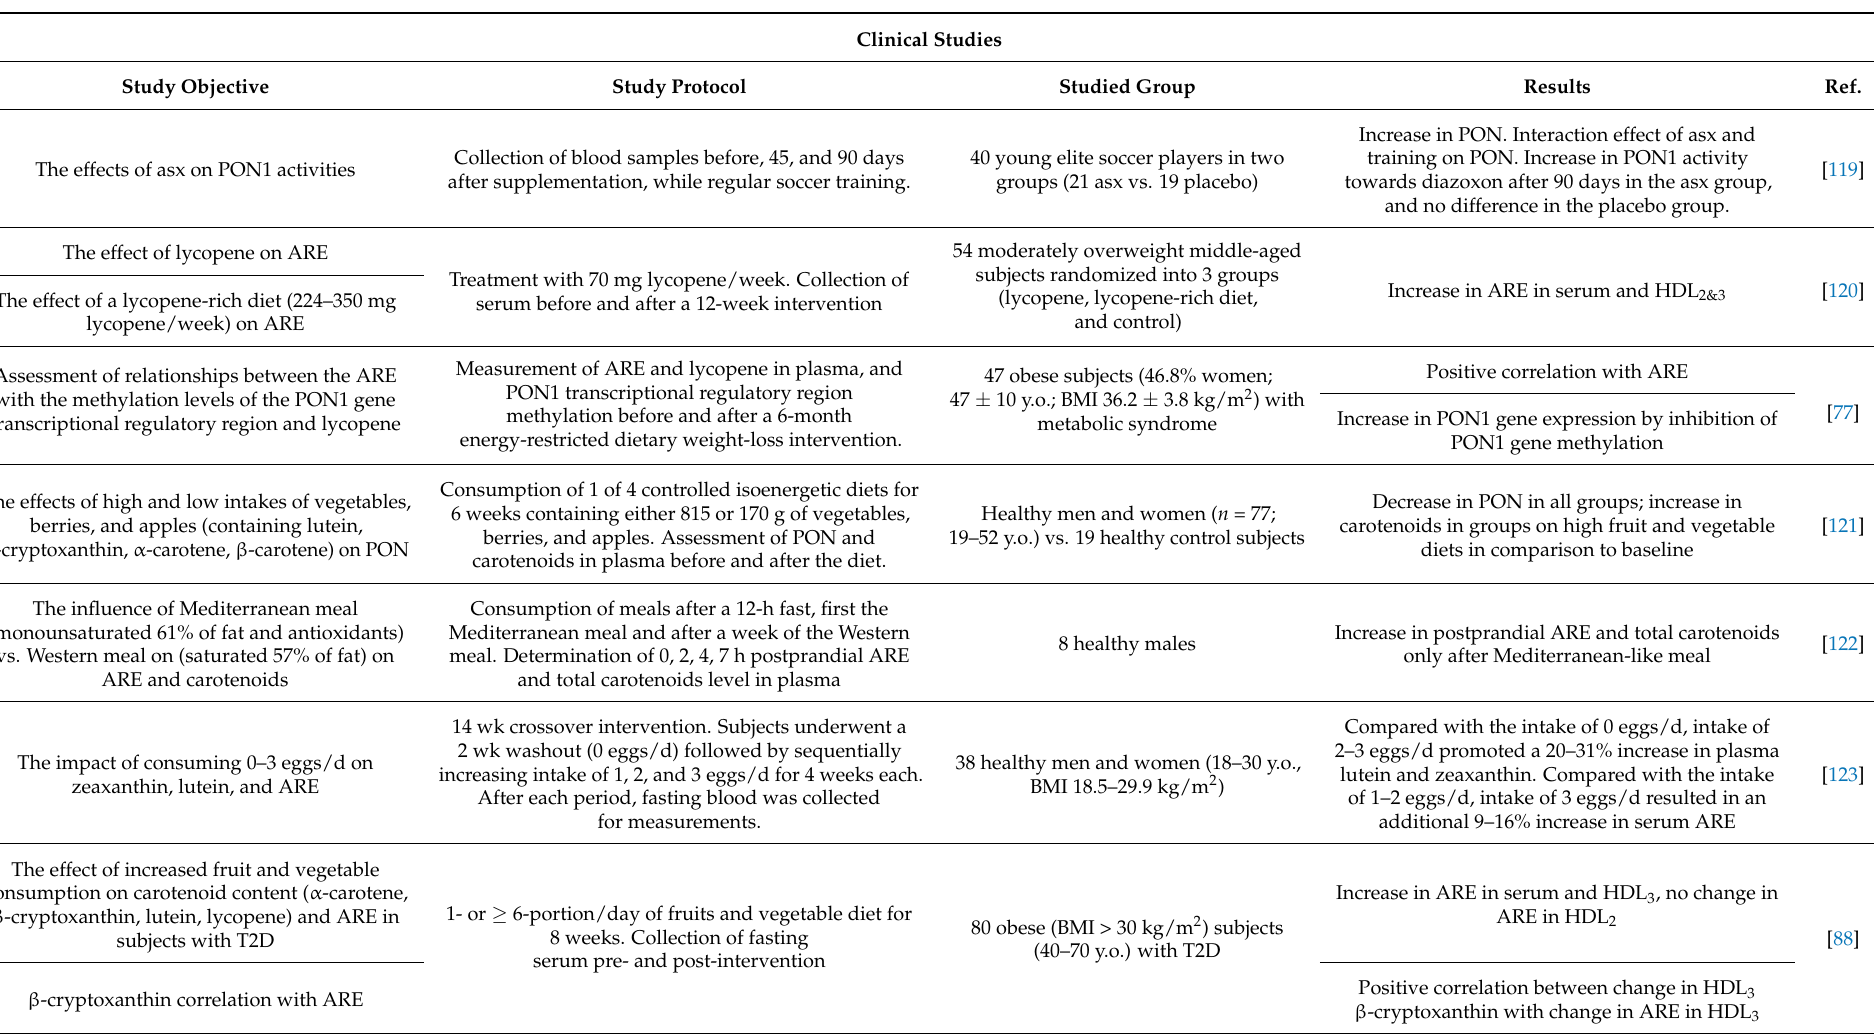
Table 4. Overview of clinical studies on the effect of carotenoids on PON1 gene expression and PON1 (paraoxonase 1)